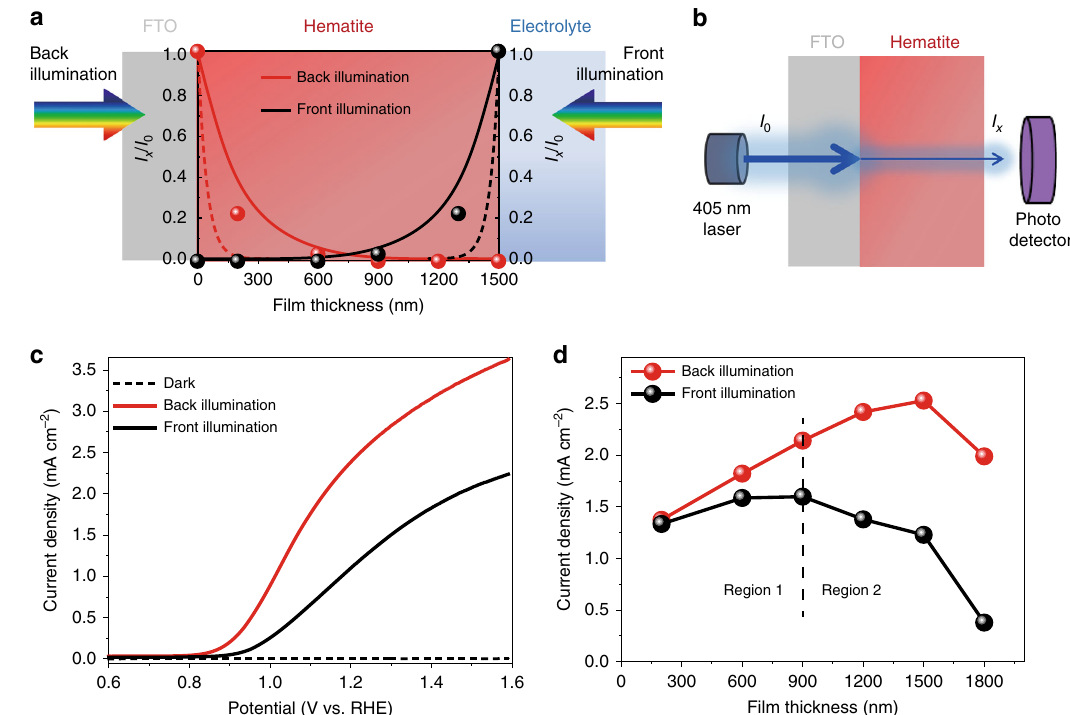
Fig. 5 Superior back illumination current generation. a Lambert – Beer law-based simulation of light intensity in hematite fi lm under different illumination modes (dash lines) and the measured light intensity in hematite with different thicknesses (dots) and the corresponding fi tted line (solid lines). b The method used to measure the light intensity ( I x / I 0 ). c The current density – voltage curves of Ti – Fe 2 O 3 MC photoanode (with thickness of 1500 nm) measured under different illumination modes. d The current densities at 1.23 V vs. RHE of the Ti – Fe 2 O 3 MC photoanodes with different fi lm thicknesses measured under different illumination